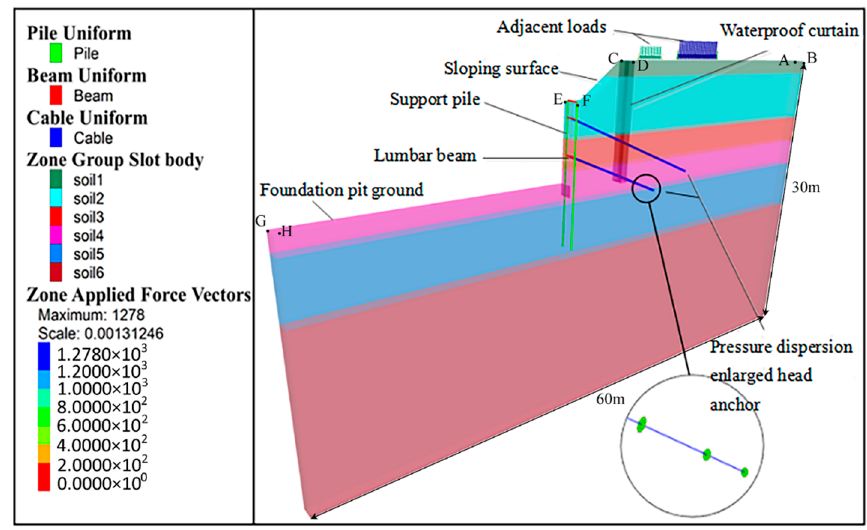
Figure 15. Model diagram of the excavation of the foundation pit to the bottom of the pit. Table 2. Soil parameters.